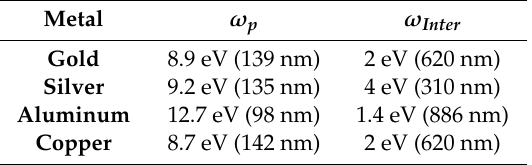
Table 2. Plasma frequency ( ω p ) and onset of the interband transitions ( ω Inter ) for some common metals used in SERS. The former values are taken from West et al. [157]; the latter are taken from Cottancin et al. [160] (gold, silver and copper) and from Ehrenreich et al. [161]